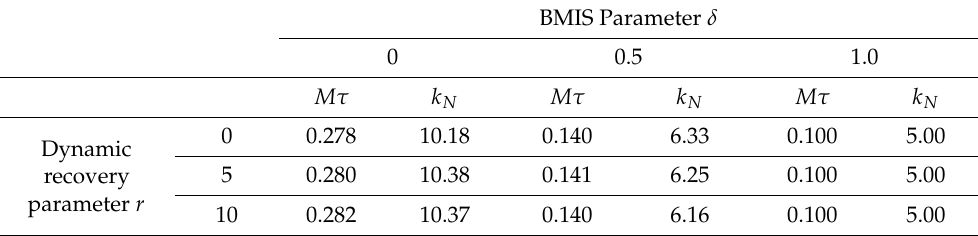
Table 3. Numerical values of the migration parameter M τ ( µ m 3 s − 1 ) and the nucleation parameter k N (10 − 9 µ m 4 s − 1 ) derived from Equation (25a,b), respectively, for various values of the dynamic recovery and BMIS